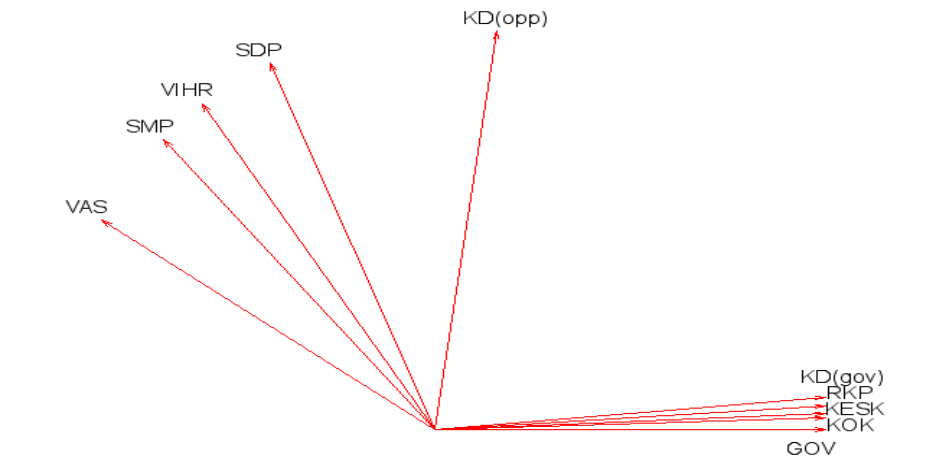
Figure 2a. Government and opposition voting during the Aho government (1991- 1994)